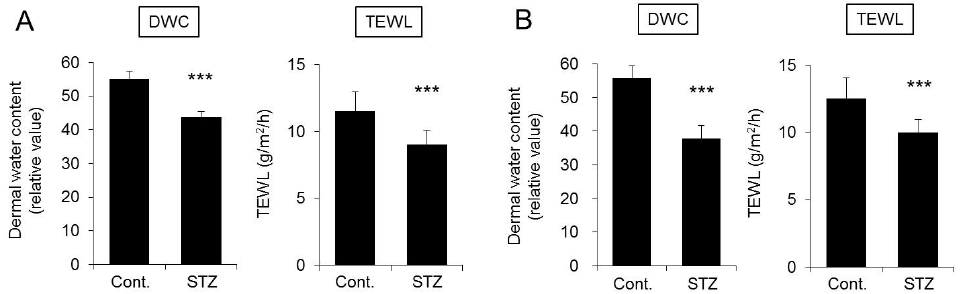
Figure 2. Dermal water content and transepidermal water loss (TEWL). Mice were given a single intravenous administration of STZ. After four weeks ( A ) or eight weeks ( B ), the dermal water content (DWC) and TEWL were measured (mean ± SD, n = 5, *** p < 0.001).